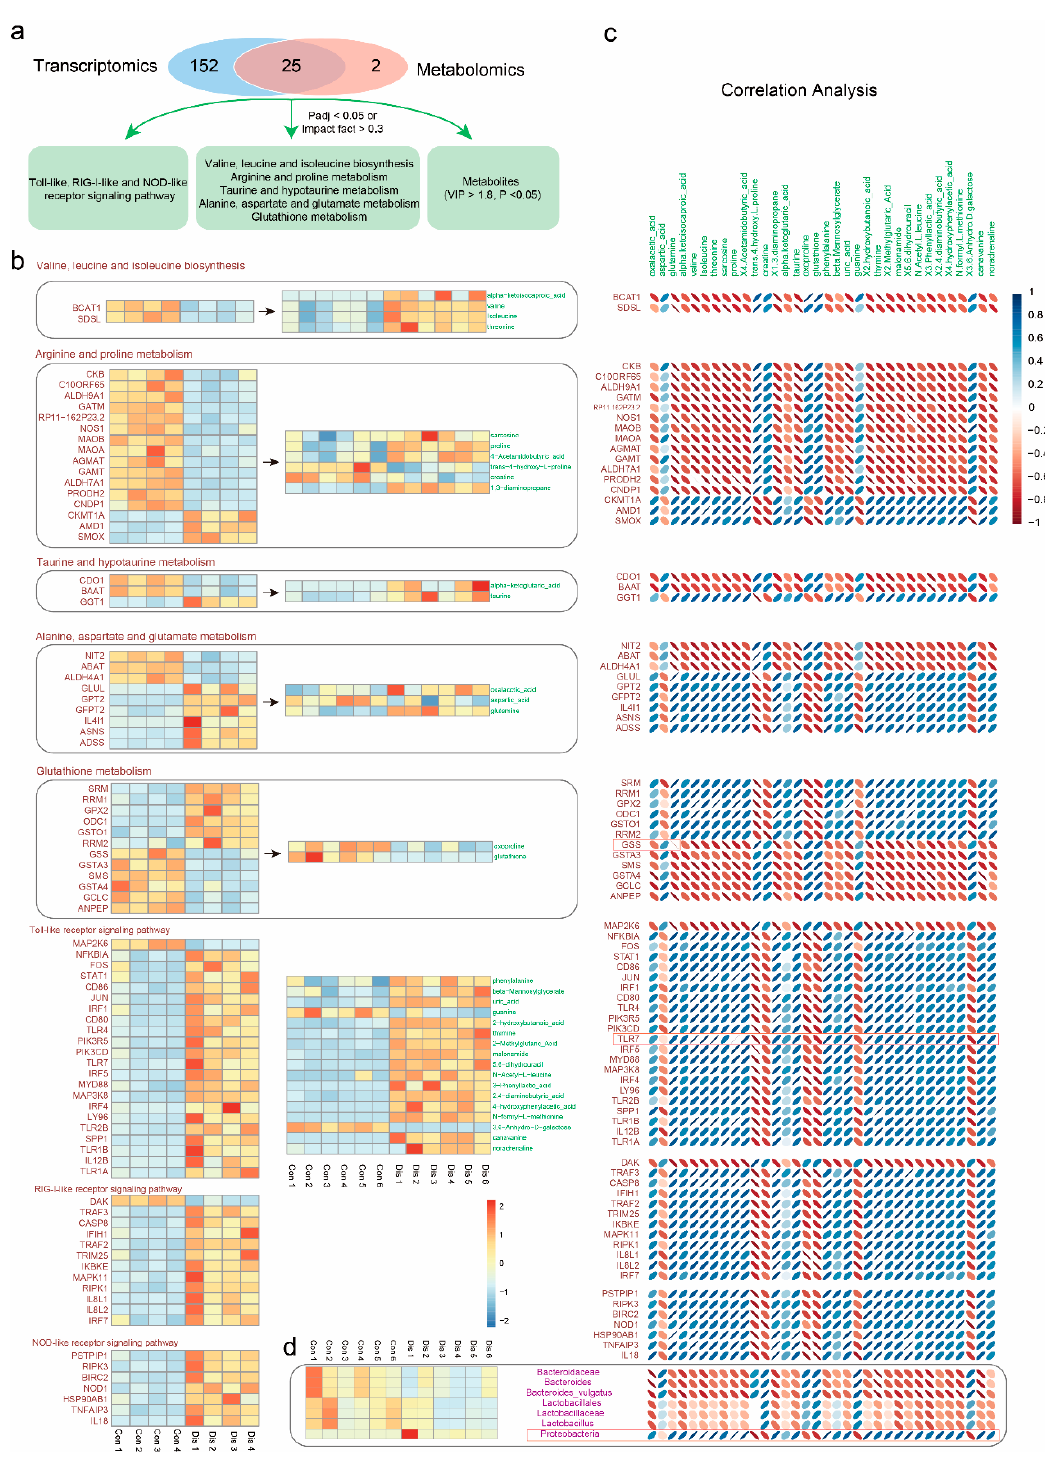
Figure 5. The significant correlation between DEGs, differential metabolites, and discriminative features of gut microbiota. ( a ) Overlap enriched pathways between metabolomics and transcriptomics. ( b ) Heat map of DEGs and metabolites used for correlation analysis. Heat map of DEDs and differential metabolites involved in overlap pathway were shown in the grey box, respectively. ( c ) Spearman’s rank correlation analysis. The color indicating the sign of the correlation, and the shape indicating the strength (narrower ellipses = higher correlations). The red bar is for highlighting. ( d ) Heat map of the discriminative features of gut microbiota and correlation plot of spearman correlation analysis between differential metabolites and discriminative features of gut microbiota.